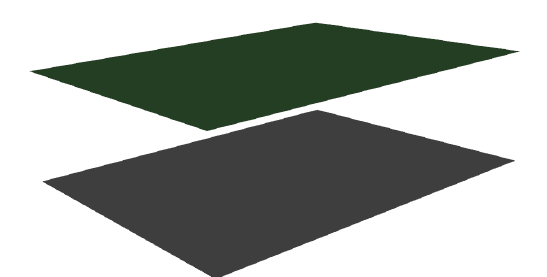
Figure 10: Generated CityGML GroundSurface and